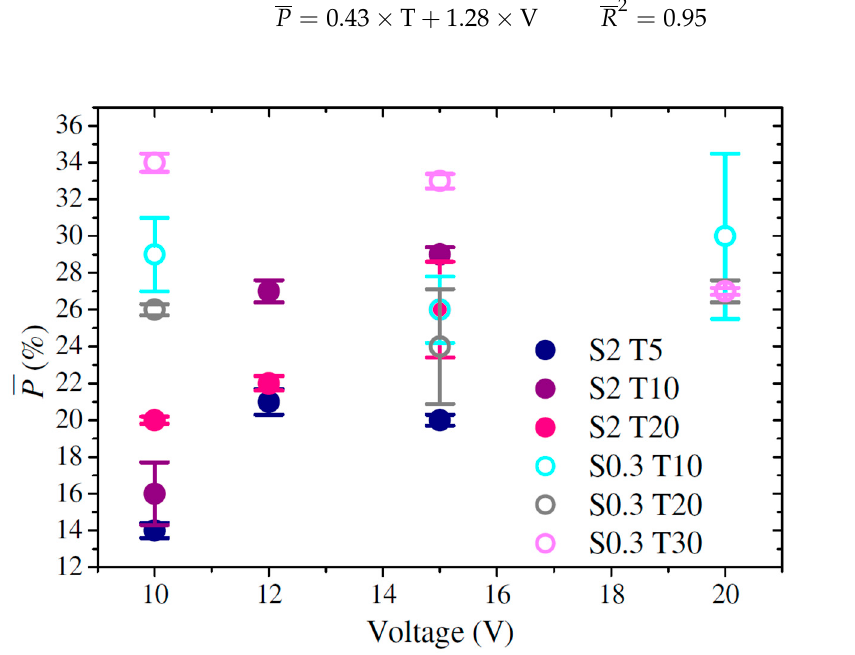
Figure 8. Variation of the average porosity of nanostructured aluminium oxide films anodized in sulphuric acid as a function of the concentration and temperature of the electrolyte and the voltage. interpore distance, pore density and porosity, and the temperature on the oxide porosity. A